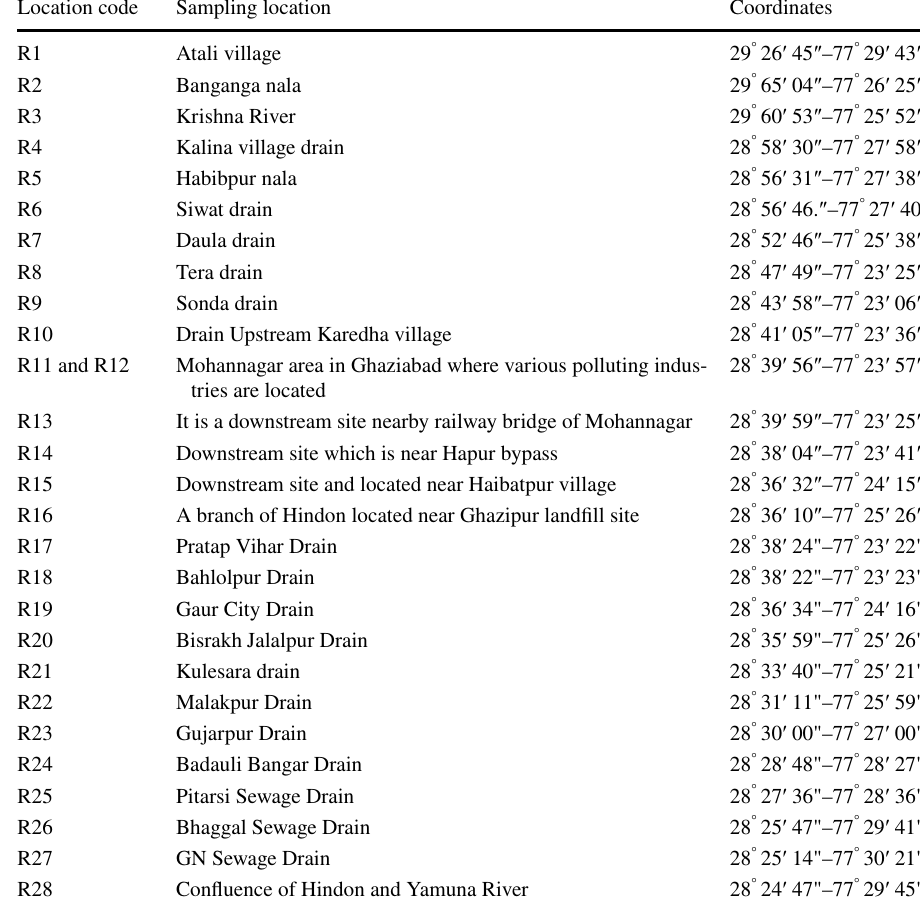
Table 1 Different surface water sampling